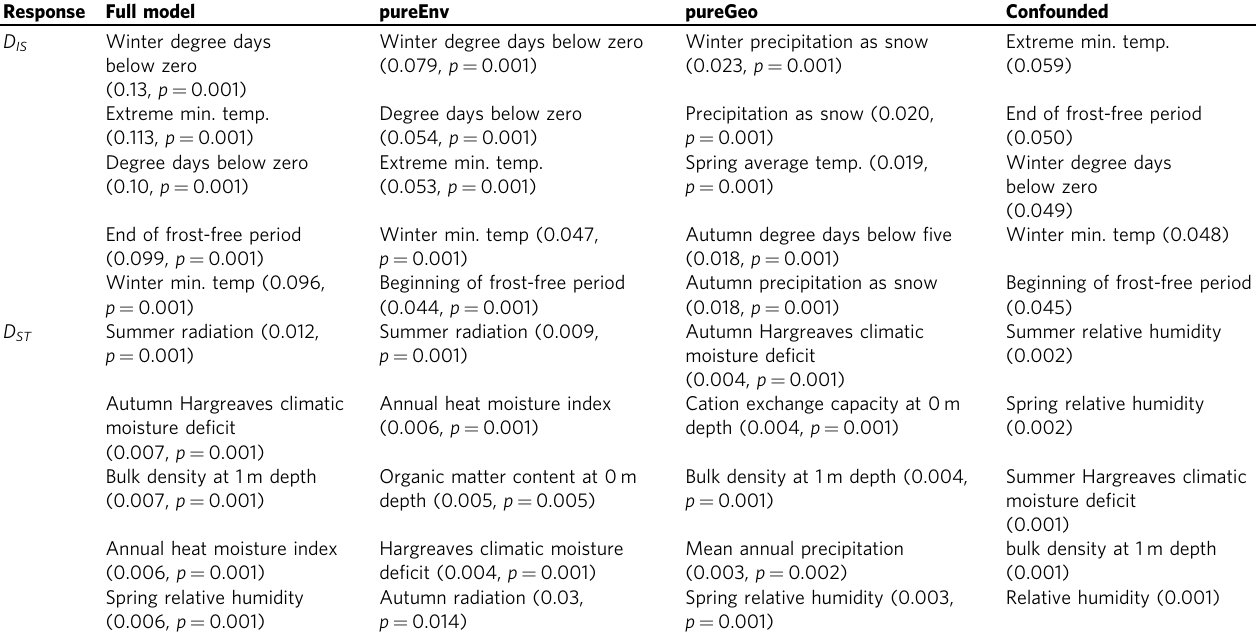
Table 2 Top fi ve environmental gradients ( R 2 and p value in parentheses) for three multivariate regression models partitioning the effect of geography and environment on the median among and within population component of LD ( D ST and D IS ). Response Full